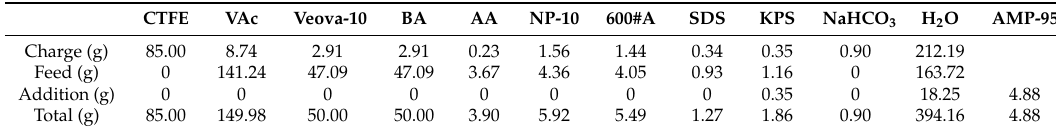
Table 1. Amounts used in the emulsion polymerization of P1 .